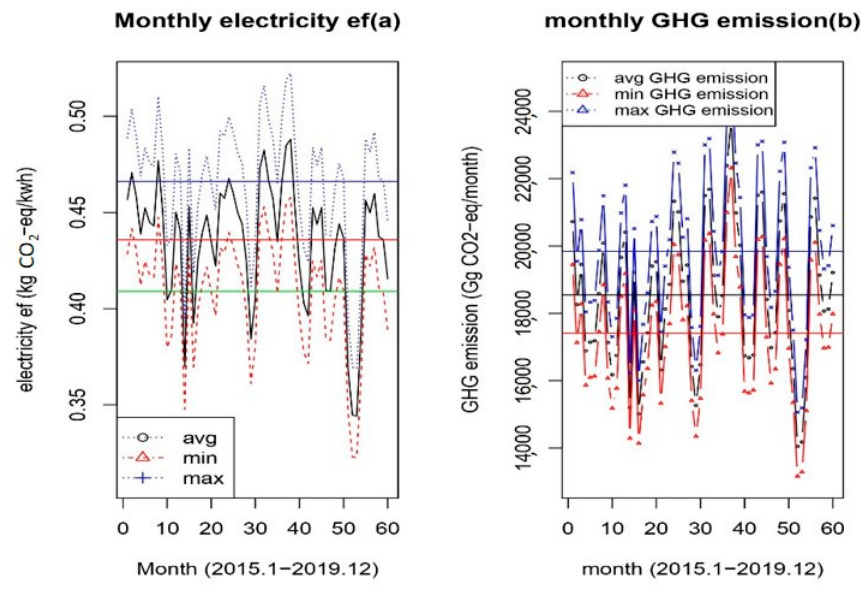
Figure 3. Monthly electricity emission factor ( a ) and monthly GHG emission ( b ).